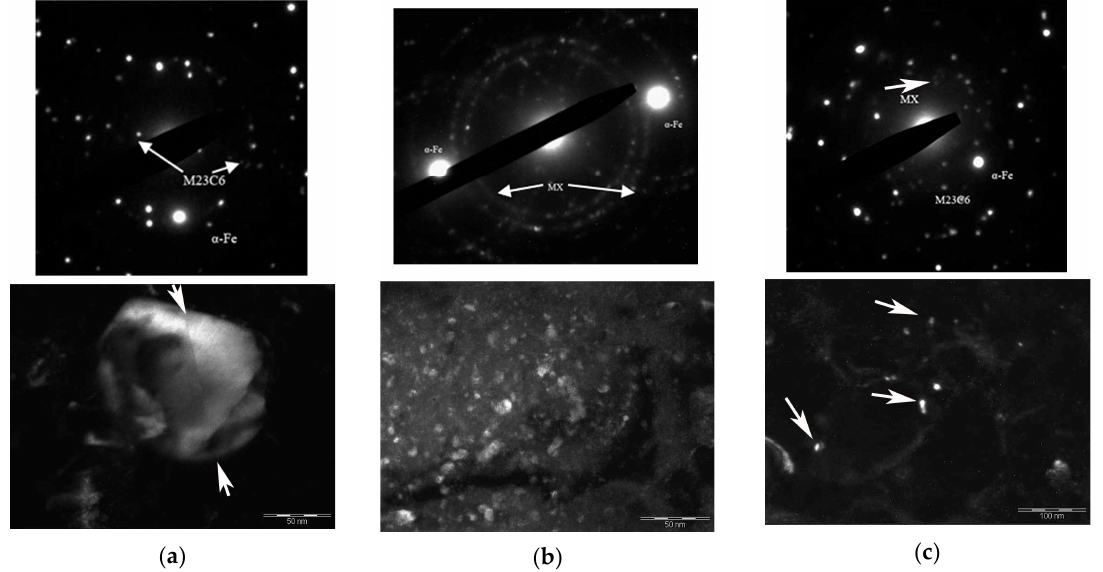
Figure 5. Diffraction patterns and dark-field TEM images showing particles after various treatments: ( a ) cutting of carbides by dislocations in steel subjected to T800 + HPT20; ( b ) МХ carbonitrides after T800 + HPT20, dark field in the spot (111); ( c ) МХ carbonitrides after T800 + HPT300 dark field in the spot (200).